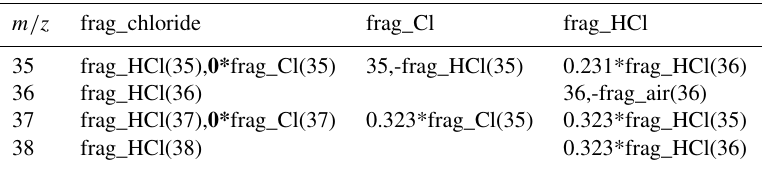
Table 1. The original fragmentation table is a combination of the frag_Cl and frag_HCl. Because of the non-ideal behavior of m/z 35, it is recommended to adapt (bold) the fragmentation table for chloride so that it is only based on